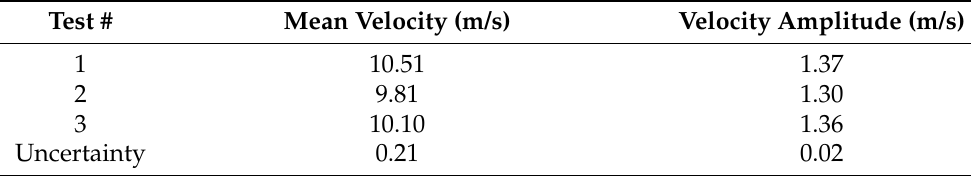
Table 1. Uncertainty evaluation for the 10 m/s tests.